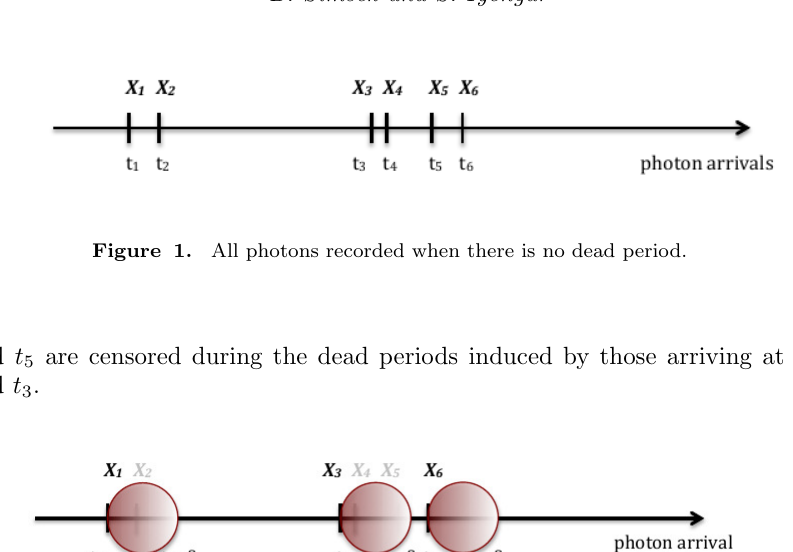
Figure 2. Shaded regions depict dead periods which censor